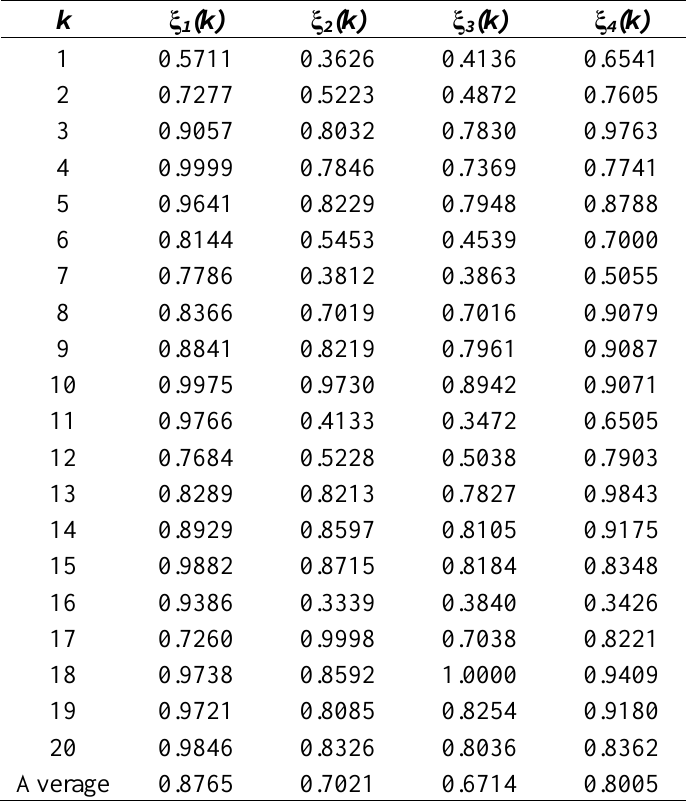
Table 9. The association coefficient of each data